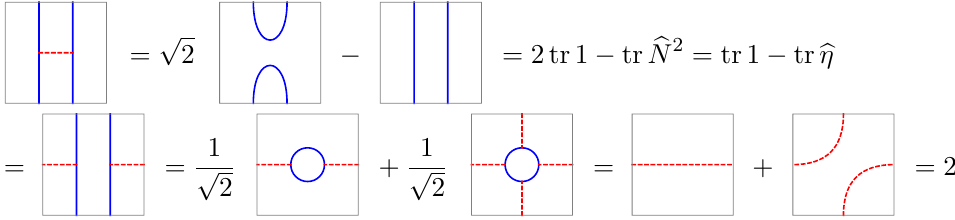
Figure 44 . The determination of tr crossing relations and modular